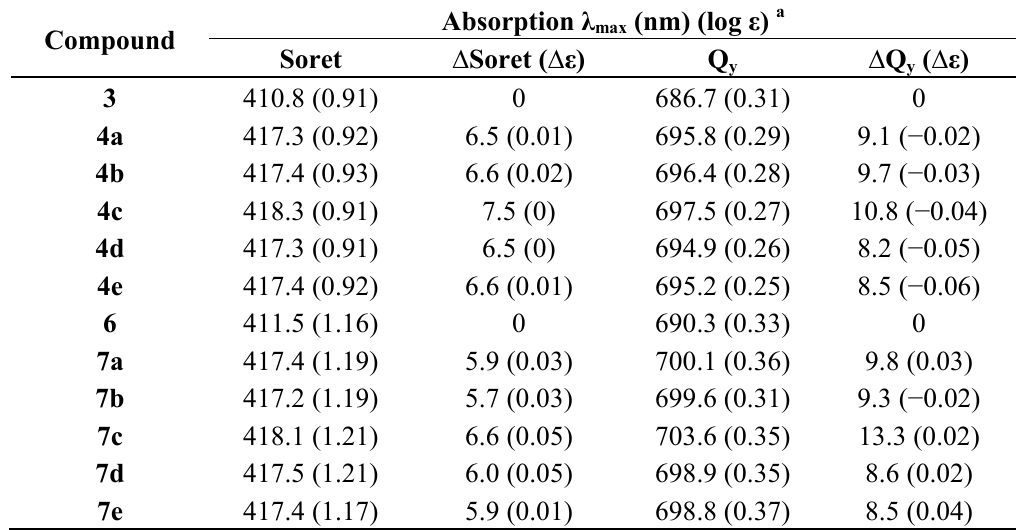
Table 1. Absorption properties of the purpurinimides ( 3 , 4a – 4e , 6 , 7a – 7e ) in CH Compound